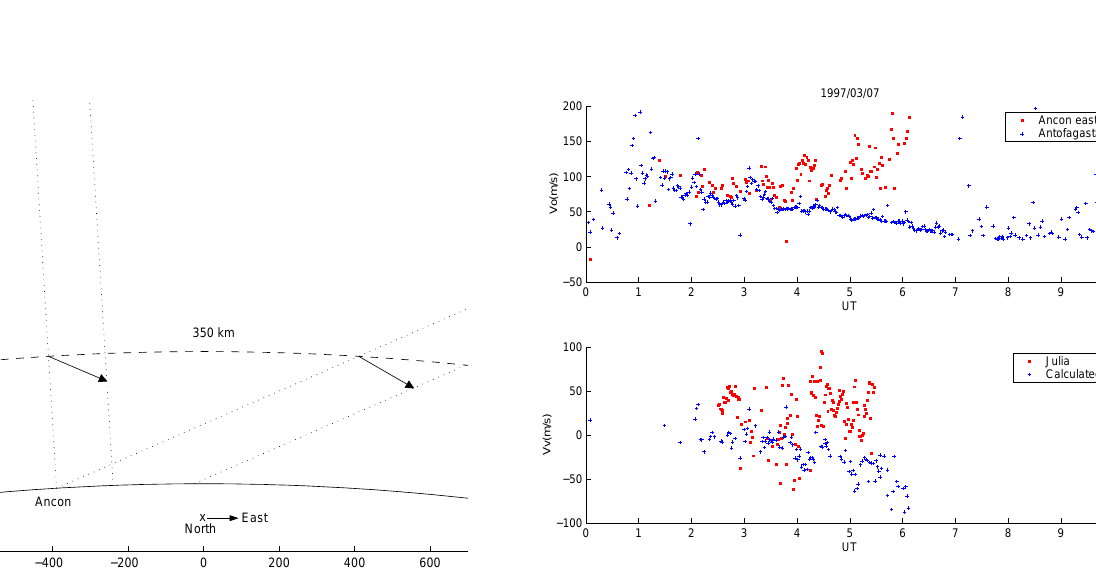
Fig. 9. (a) Top panel: Observed V 0 drift velocities at Ancon-E and Antofagasta on 7 March 1997. Bottom panel: Observed Julia radar vertical drifts and vertical drifts calculated from Ancon-E and Antofagasta V 0 in top panel. Julia data is displaced 1.5h later to account for zonal drift.